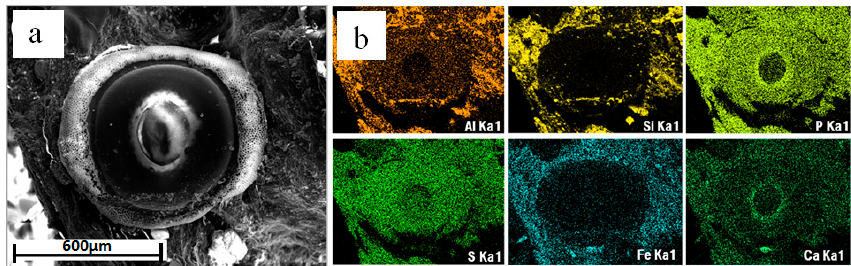
Figure 5. SEM-EDS elemental distribution maps of Asajirella gelatinosa collected from Kahokugata Lake . Elemental content maps indicated in this area associated with Asajirella gelatinosa . SEM image ( a ) Elemental content maps ( b ).